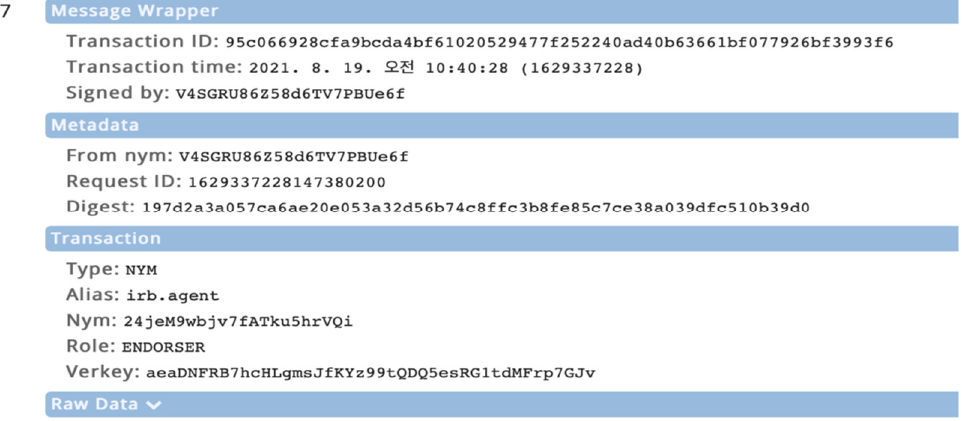
Figure 11. The result of a transaction when registering IRB in von-network.